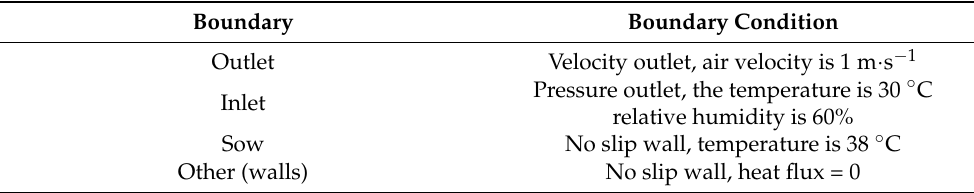
Table 2. Boundary conditions of each surface in Computational fluid dynamics